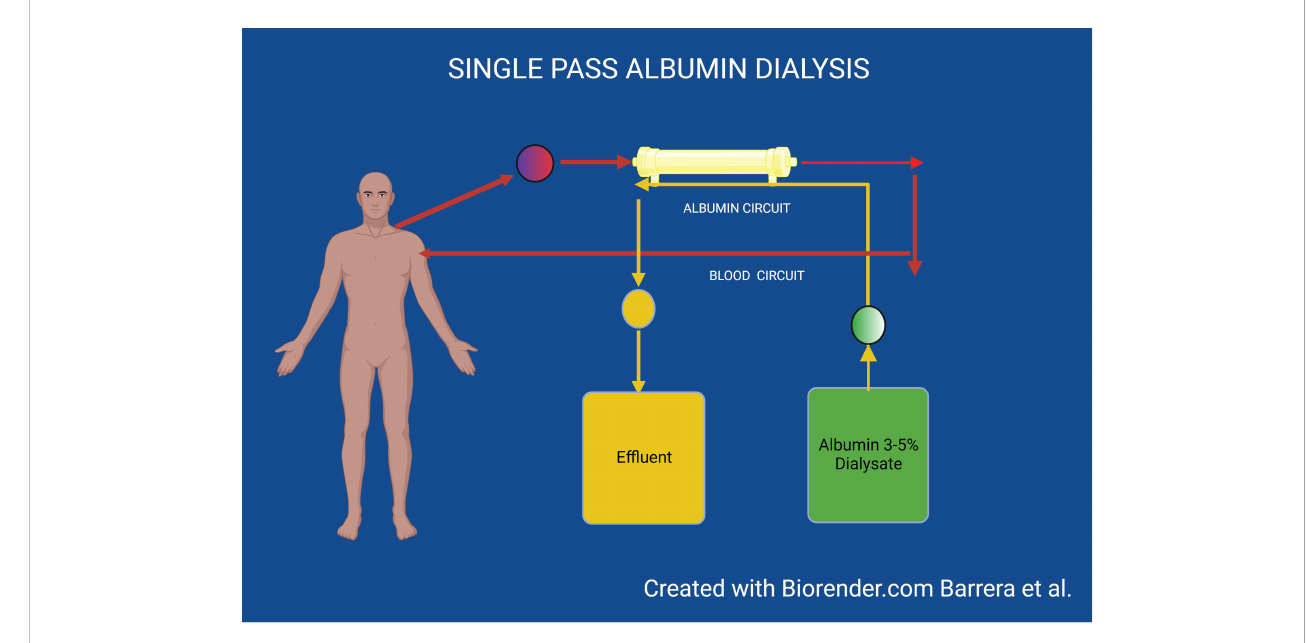
FIGURE 3 Single pass album